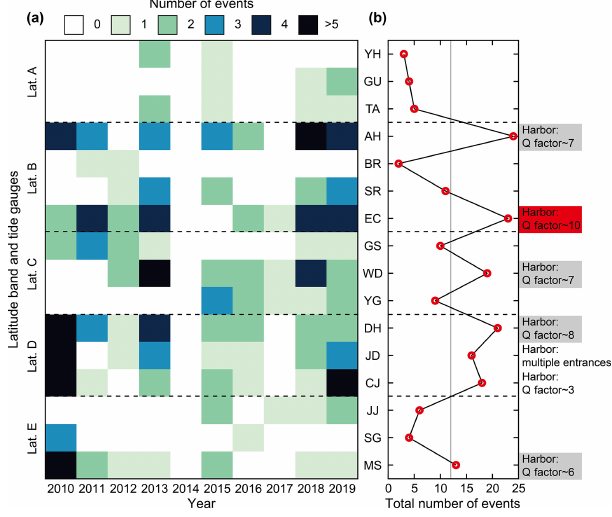
Figure 6. Spatial pattern of meteotsunami occurrences: (a) num- ber of events per year and (b) total number of events. Gray lines indicate average occurrences at the tide gauges (11.8). Geometric features are presented for the basins that have greater-than-average occurrences at their tide gauges. The tide gauges where the most events occurred at each latitude band and located in the harbor with the largest quality factor ( Q factor) are highlighted in gray and red,